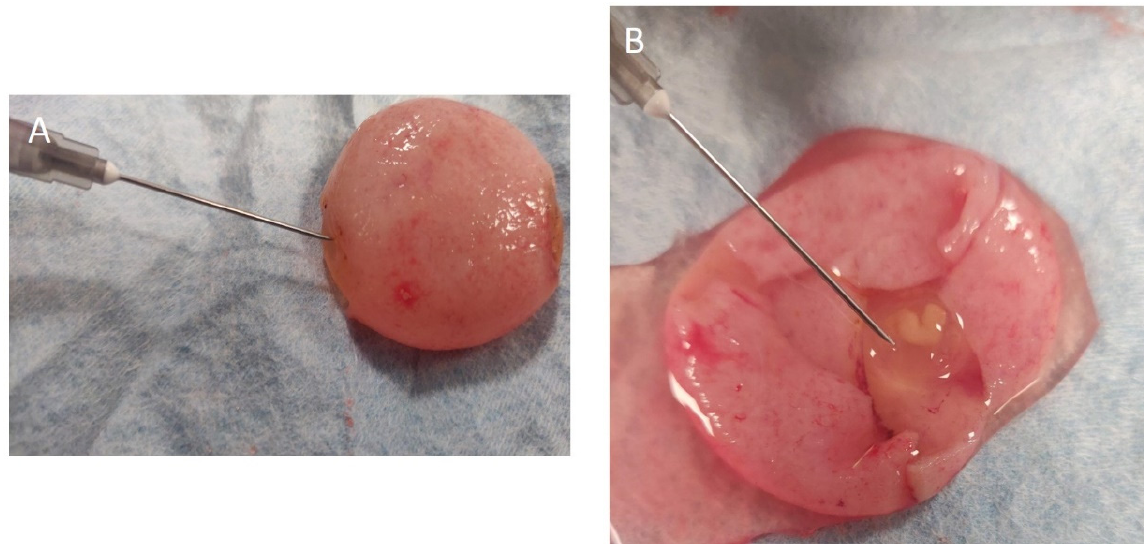
Figure 5. Withdrawal of fetal fluids. The fluid collection was made using a 23G needle connected with a 2.5 mL syringe. ( A ) Sampling of allantoic fluid from a pregnancy of about 20 days. ( B ) Collection of the amniotic fluid from the same embryonic vesicle.